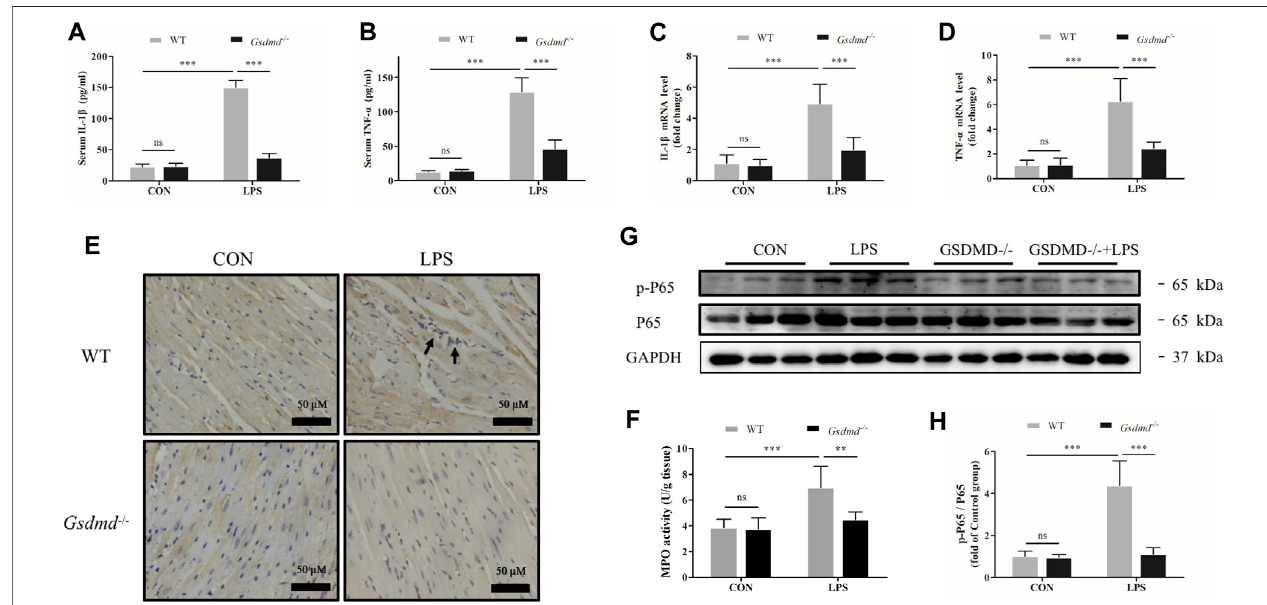
FIGURE 3 | Gsdmd de fi ciency attenuated in fl ammatory cytokine secretion, cardiac in fl ammation, and activation of the NF- κ B signaling pathway induced by LPS. (A,B) The levels of Interleukin-1 β (IL-1 β ) and Tumor necrosis factor- α (TNF- α ) in serum from each group were detected by ELISA (n (cid:1) 8). (C,D) The mRNA levels of IL-1 β and TNF- α in heart tissue from each group were detected by PCR. The results were normalized to the expression of β -actin (n (cid:1) 8). (E) Representative CD68 immunohistochemistry images of heart tissue from each group (magni fi cation × 400). Arrow heads indicate positive staining. (F) MPO activity in heart tissue from each group (n (cid:1) 5). (G,H) Expressions of NF- κ B P65 and phosphorylated P65 protein in heart tissue were measured by Western blotting analysis. The results were normalized to the expression of P65 (n (cid:1) 6). Data are expressed as the mean ± SD. ** p < 0.01, *** p <